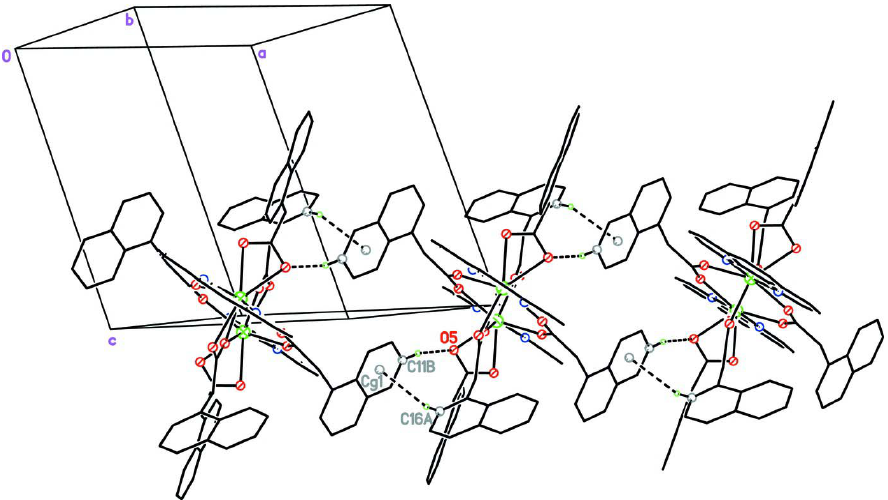
Figure 1 The molecular structure of (I), showing the atom-labelling scheme. Displacement ellipsoids are at the 30% probability level. Unlabelled atoms bonded to Sm or Eu are related to labelled atoms by (2 - x , 2 - y , 2 - z ). For clarity, H atoms have been omitted.